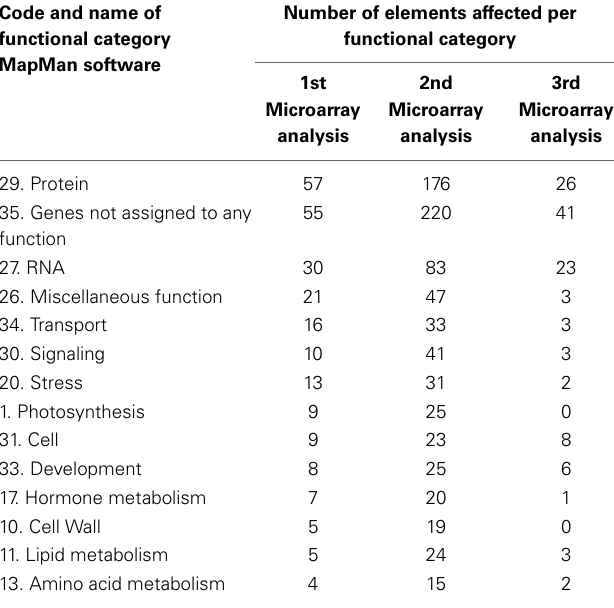
Table 2 | MapMan Bins (functional categories of genes) with more elements (“genes”) affected by endophyte inoculations in the microarray